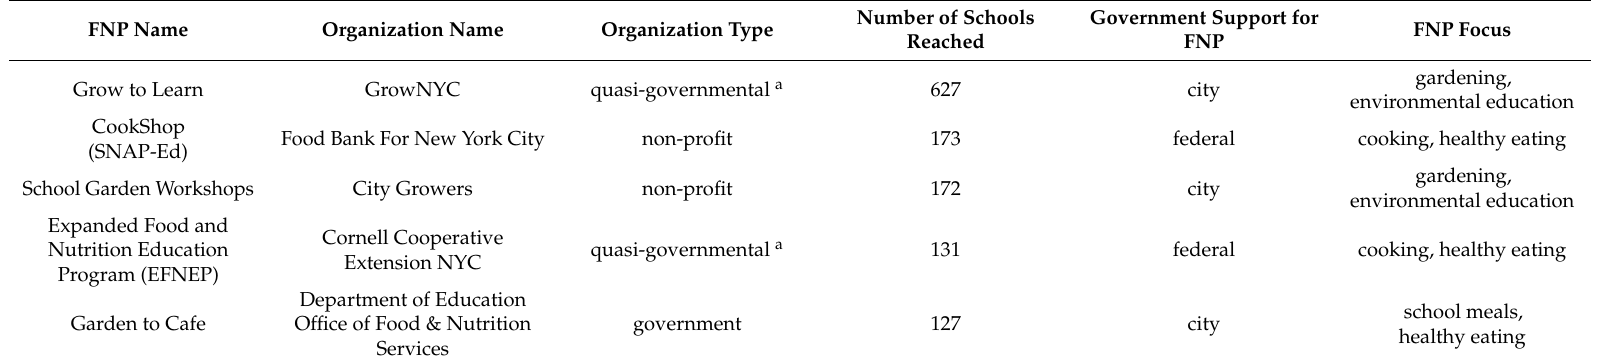
Table 3. Snapshot of the (cid:48)(cid:48) Very Large (cid:48)(cid:48) Food and Nutrition Education Programs.